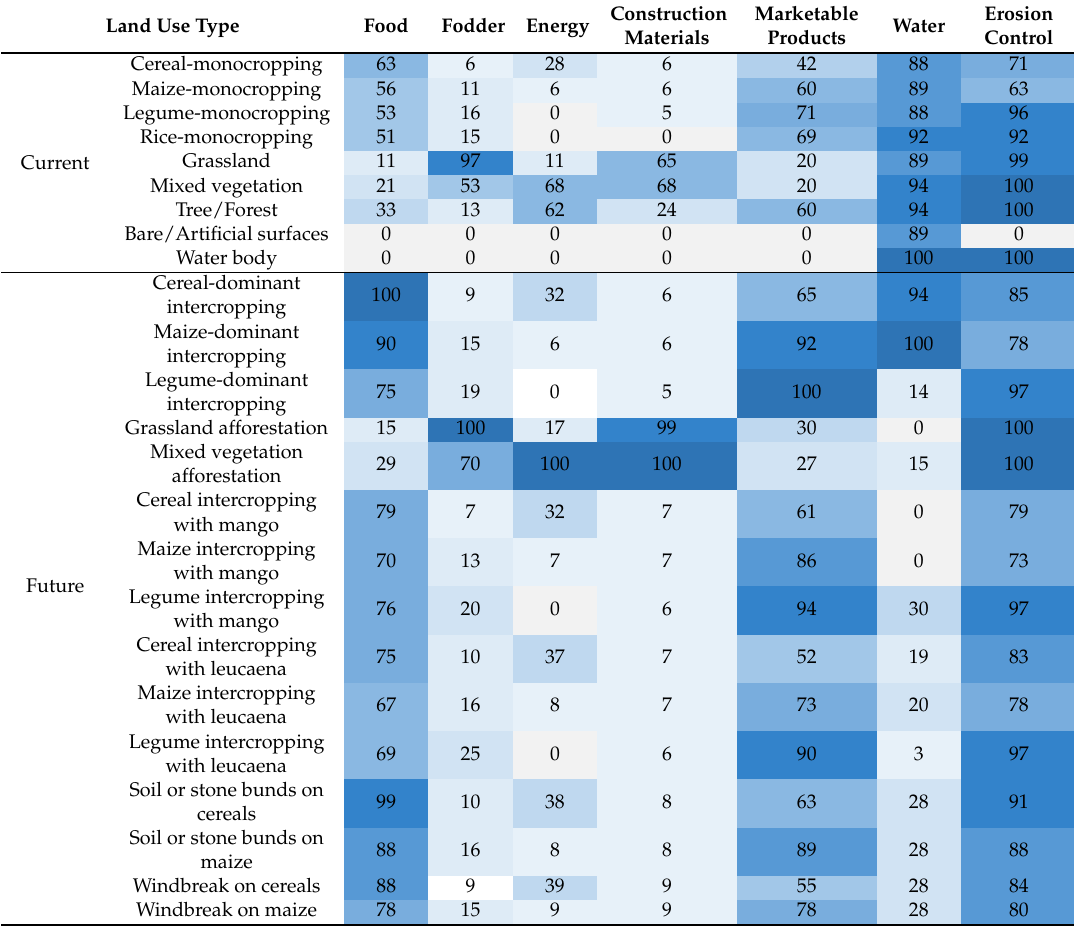
Table 5. Assessment matrix for Bongo to display the relationship between current and future land use types and their potential to provide the selected ecosystem services within a scale from 0 (no provision, in white) to 100 (highest level of provision, in dark